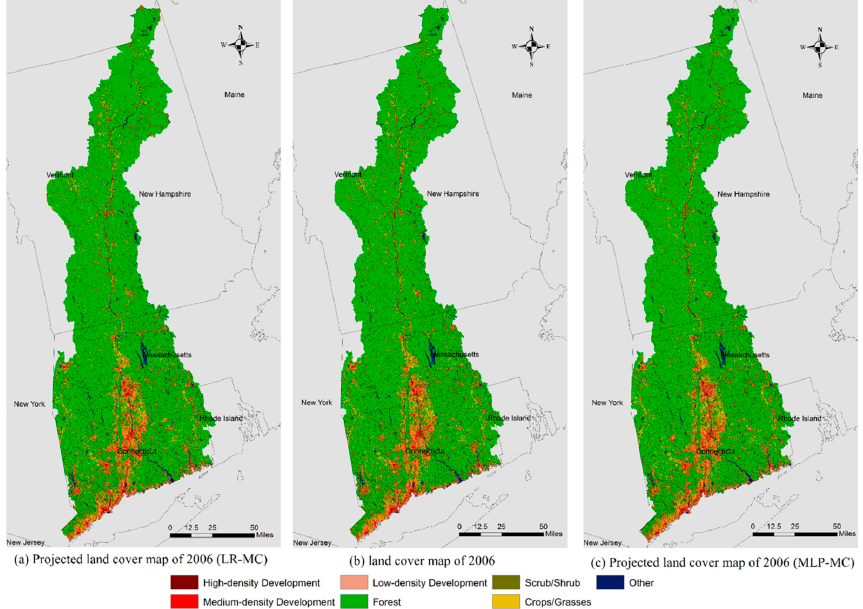
Figure 3. ( a ) Projected 2006 land cover/use map by LR–MC model, ( b ) actual 2006 land cover/use map, and ( c ) projected 2006 land cover/use map by MLP–MC model. map, and ( c ) projected 2006 land cover/use map by MLP–MC